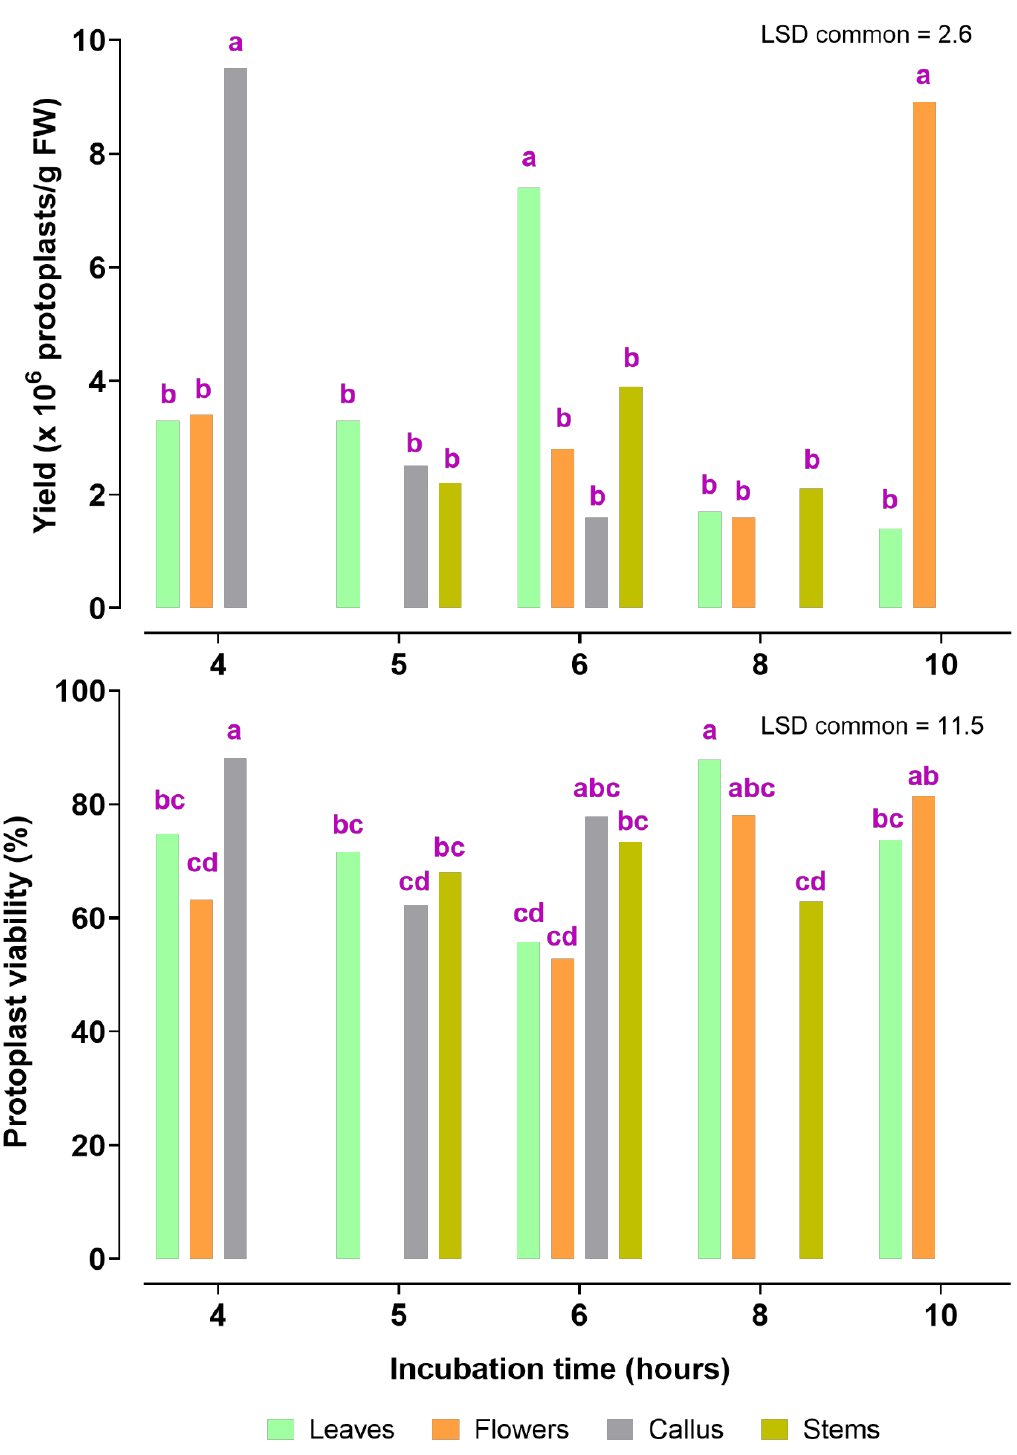
Figure 3. Effect of enzymolysis time on protoplast yield and viability of J. sambac L. protoplasts isolated from different sources (leaf, flower, stem, and callus tissues). The results were obtained in different hours of enzymolysis under constant temperature 26 °C. Values represent the means of three replicates. Means labeled by the same letter are not significantly different at p < 0.05 according to the least significant difference test.